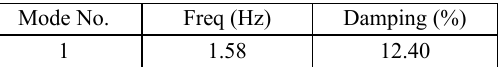
Fig. 10. Analyzed time series of active power in lines.